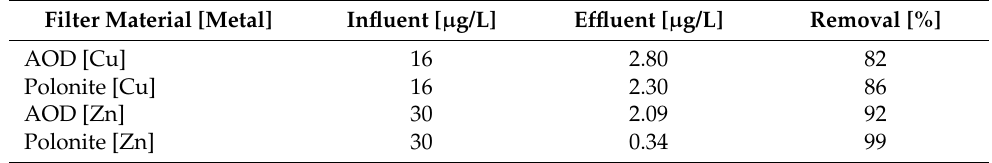
Table 3. Average removal efficiencies of the studied filter media in the PBR experiment. Filter Material [Metal] Influent [ µ g/L] Effluent [ µ